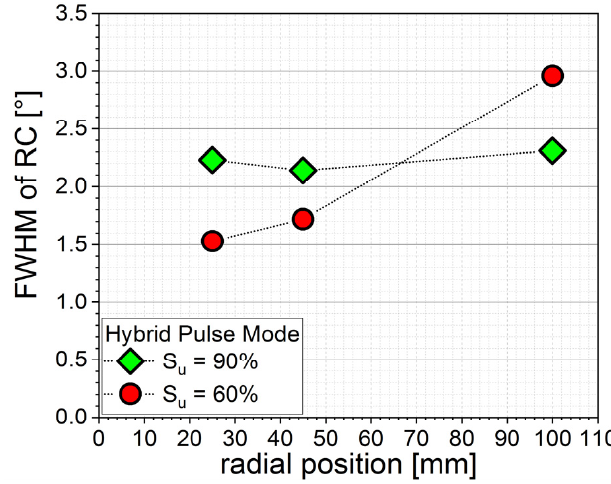
Figure 5. FWHM of (002) rocking curve of 2.5 µ m films depending on radial position and pulse mode.